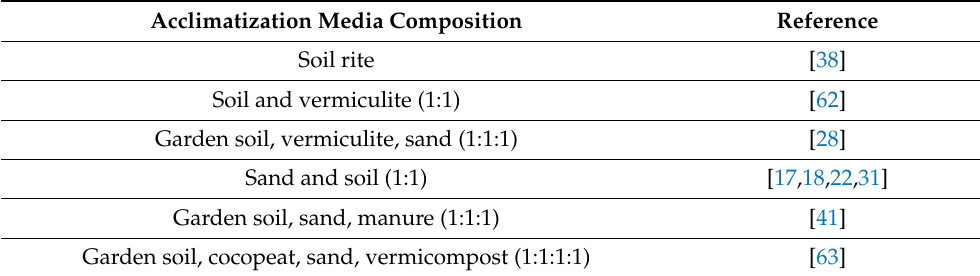
Table 4. Various acclimatization media for establishment of regenerated